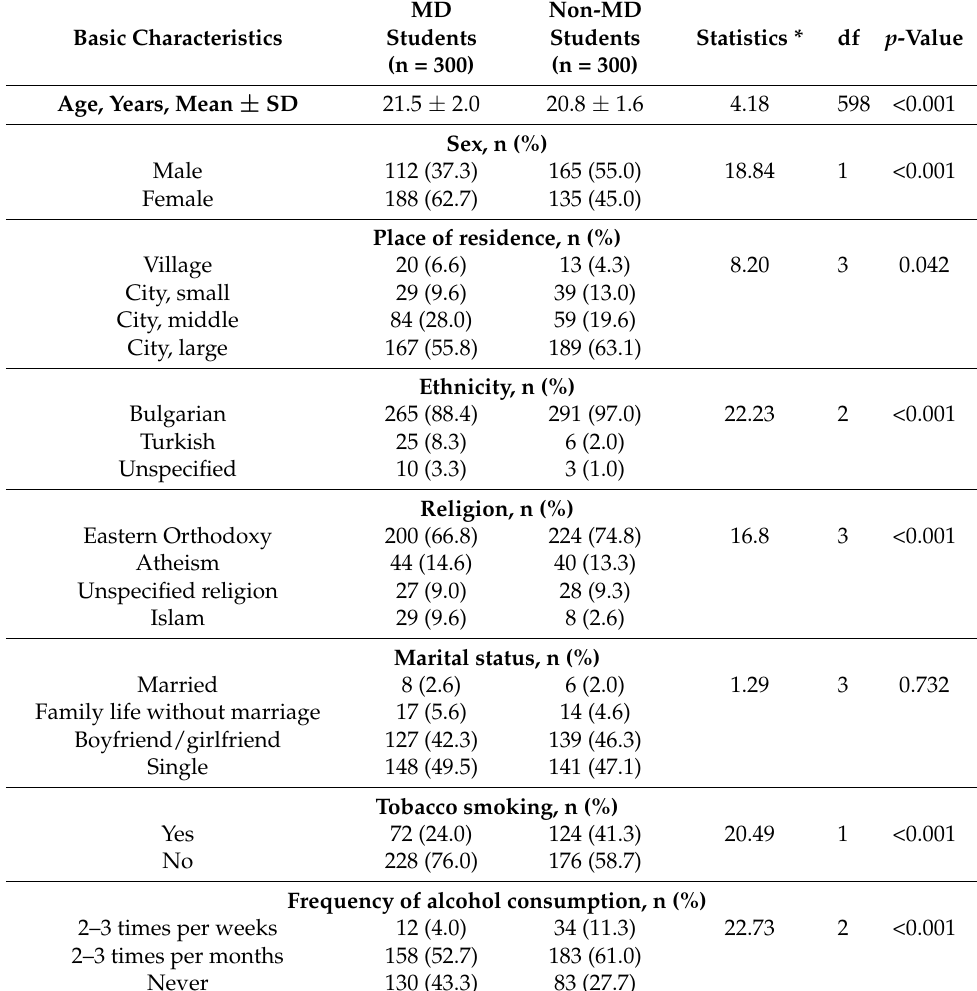
Table 1. Basic characteristics among Bulgarian MD students and Bulgarian non-MD students.